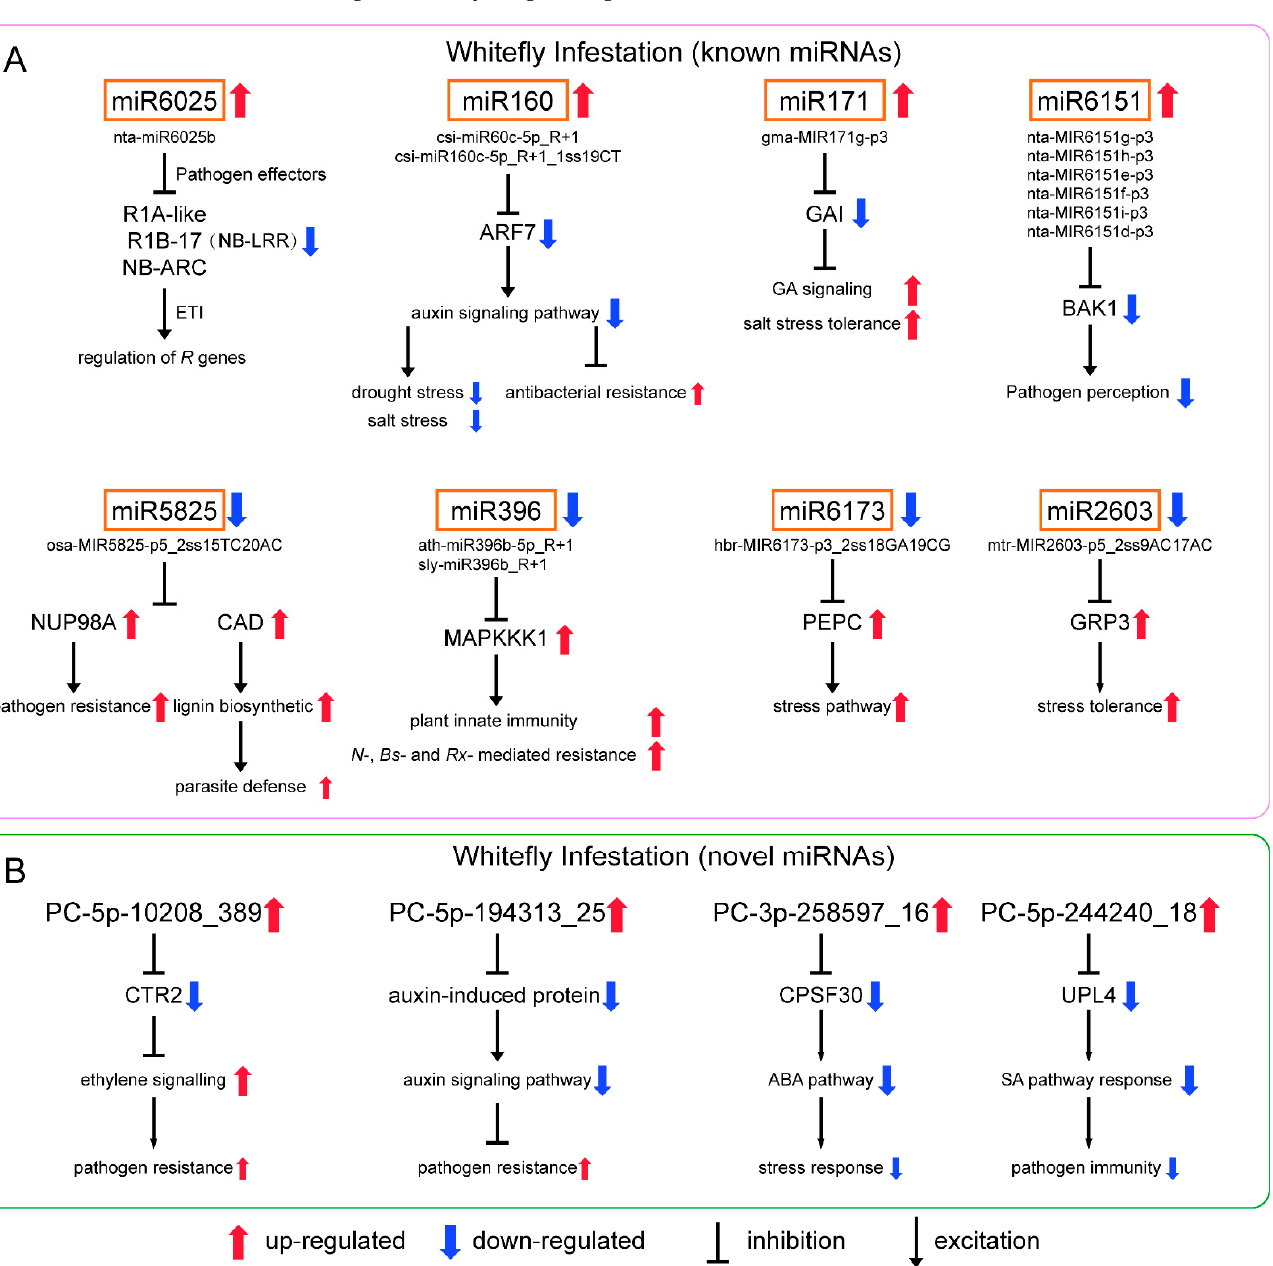
Figure 5. Potential regulatory networks of ( A ) known miRNAs and ( B ) novel miRNAs in N. tabacum infested by whiteflies.